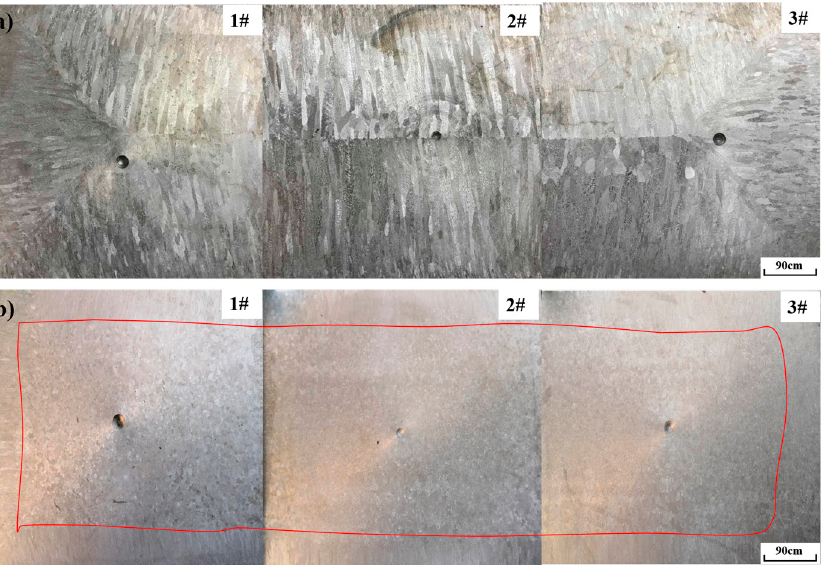
Figure 12. Cross-section of the as-cast macrostructure of the strand ( a ) without R-EMS and ( b ) with two pairs of rollers used in R-EMS (at 400 A and 7 Hz). two pairs of rollers used in R-EMS (at 400 A and 7